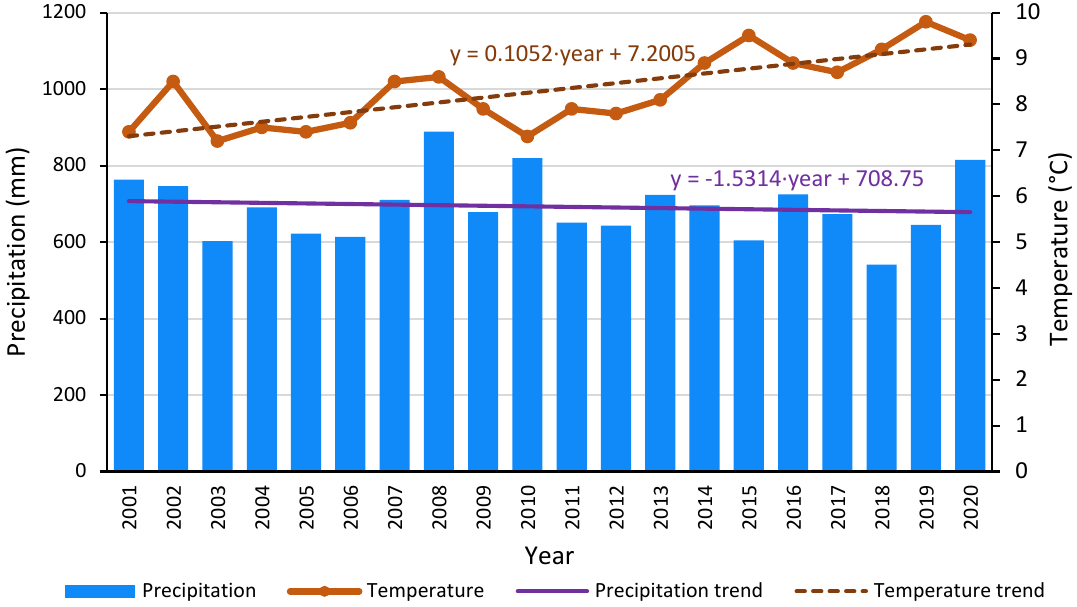
Figure 5. Changes in precipitation and air temperature in years 2001–2020. Regression lines obtained in the analysis of the trend in the amount of precipitation in the cold period (Figure 6a) indicate that precipitation fell annually by 2.62 mm, which corresponds to a decrease of 52.5 mm between the beginning and end of the study period (the years 2001 and 2020) ( r = − 0.32, p = 0.174). In the warm period (Figure 6b), a slight upward trend was recorded, with precipitation increasing by 1.09 mm annually (21.9 mm over the 20-year period, r = 0.08, p =